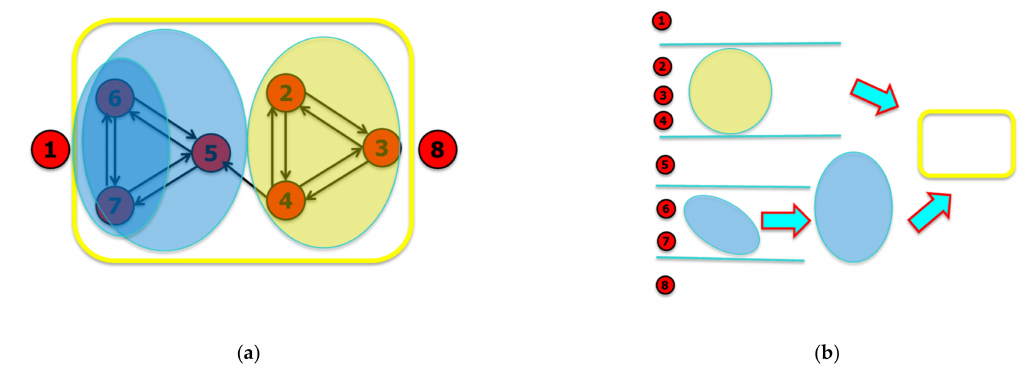
Figure A3. Final results of the iterated sieving algorithm: ( a ) The nesting of the observed dynamic groups (superimposed on the diagram showing the connections between the variables). The variables 1 and 8 are random variables separated from the system at work (the group highlighted here by the yellow box). Each variable performs the XOR of its input variables, except for node 5 that sets node 4 in AND with the XOR of nodes 6 and 7. ( b ) The hierarchy identified by the succession of groupings carried out by the zI